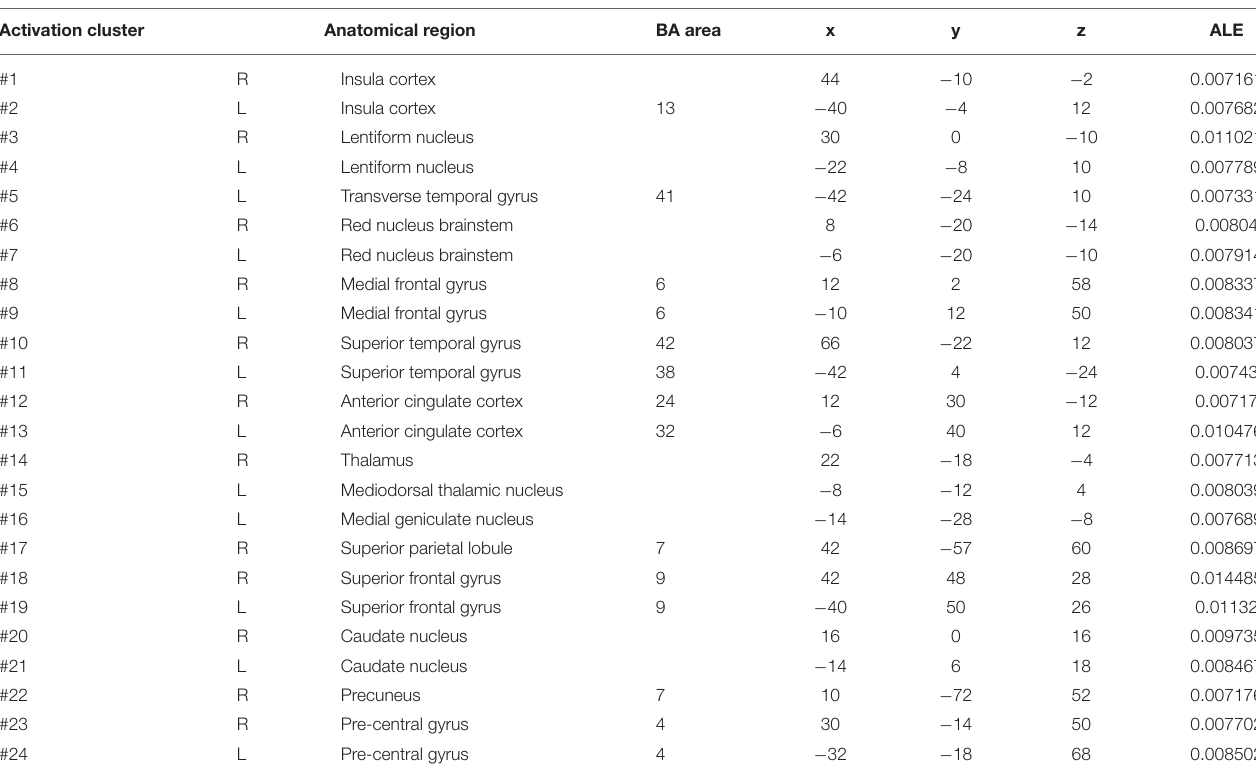
TABLE 5 | Clusters with HC > PD activation in cue-priming conditions. Activation